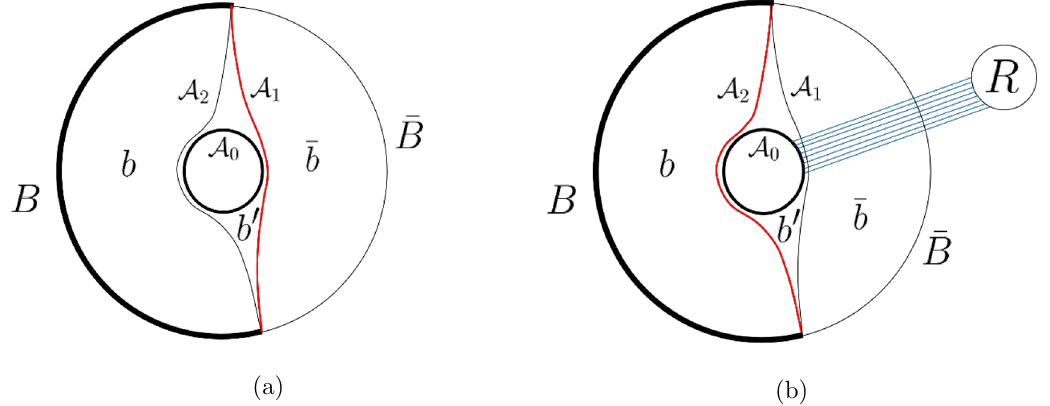
Figure 11. The exterior geometry of a black hole, with horizon area A 0 , in AdS/CFT. The bound- ary is divided into two regions B and (cid:22) B ; there exists a locally minimal surface separating B from (cid:22) B on either side of the black hole, with areas A 2 and A 1 . These divide the bulk into three regions b , b 0 and (cid:22) b , where region b 0 lies between the two minimal surfaces and contains the black hole. If A 2 > A 1 , region b 0 is contained in the entanglement wedge of region B for all pure microstates, shown in (cid:12)g- ure 11a. However, if the black hole is entangled with a reference system with S bulk = 4 G N > A 2 (cid:0)A 1 , as shown in (cid:12)gure 11b, the Ryu-Takayanagi surface will jump to A 2 and the entanglement wedge of B will no longer contain region b 0 . As a result, a state-independent reconstruction of region b 0 on region B only exists for code spaces of microstates with dimension jH code j (cid:20) e ( A 2 (cid:0)A 1 ) = 4 G N